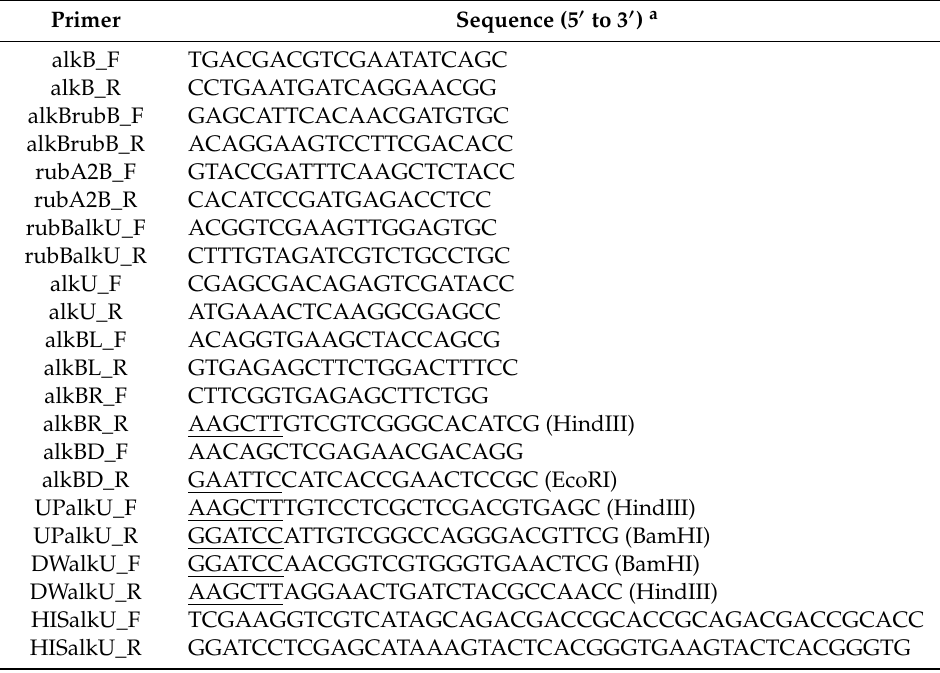
Table 2. Primer sequences used in this